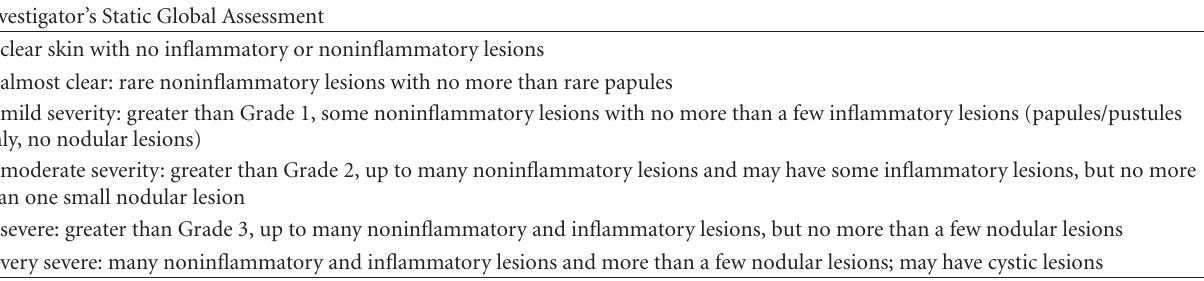
Table 1: Investigator’s Static Global Assessment.